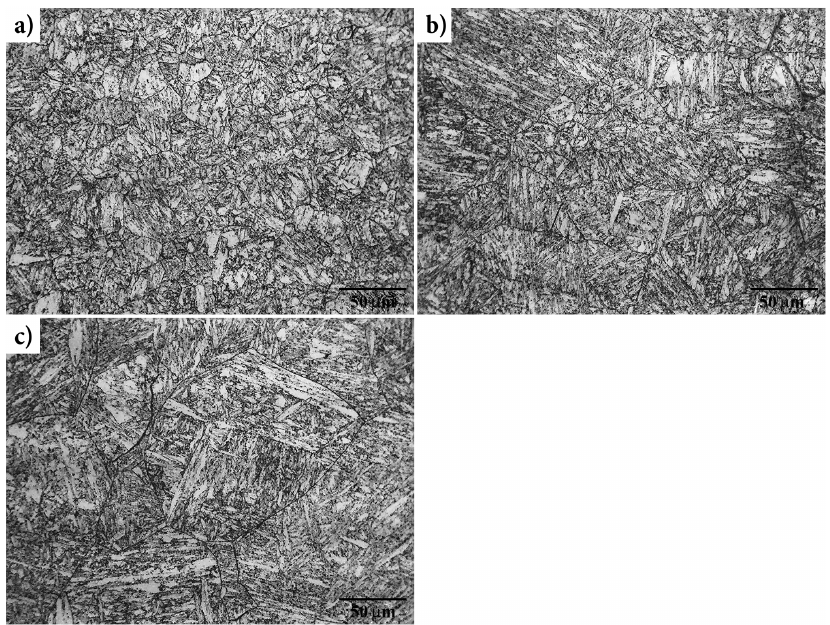
Figure 2: Microstructure of T92 steel samples solutionized at (a) 1,050°C, (b) 1,100°C, (c) 1,150°C and tempered at